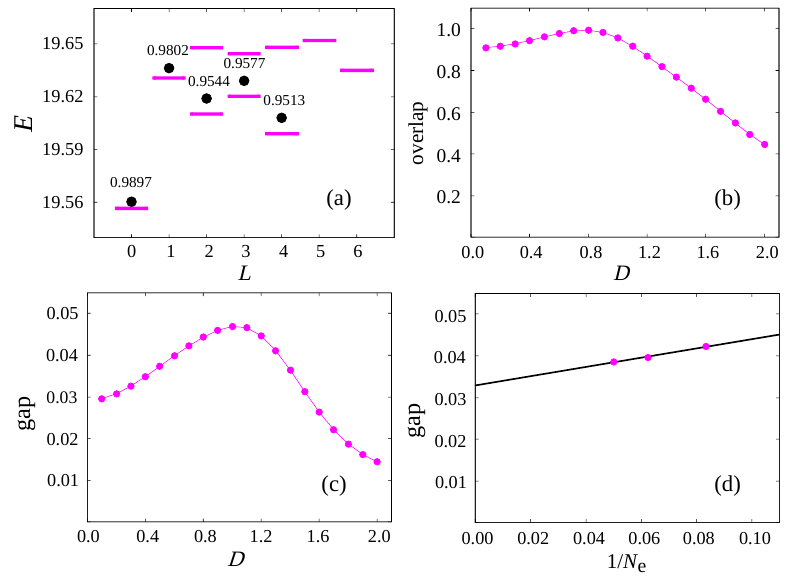
Figure 4: Numerical results about the Ψ 221 state. The system parameters are − 1,2 = 6, N b = 6, N t = 11, N b = 17 in panels (a-c). (a) The energy spectrum at N t φ φ e e D = 0.7. The symbols are the same as in Fig. 3. (b) The overlaps between the ex- act ground state and the trial state at different D . (c) The neutral gaps at different D . (d) Finite size scaling of the neutral gap versus the total number of electrons = N t + N b N at D = e e e